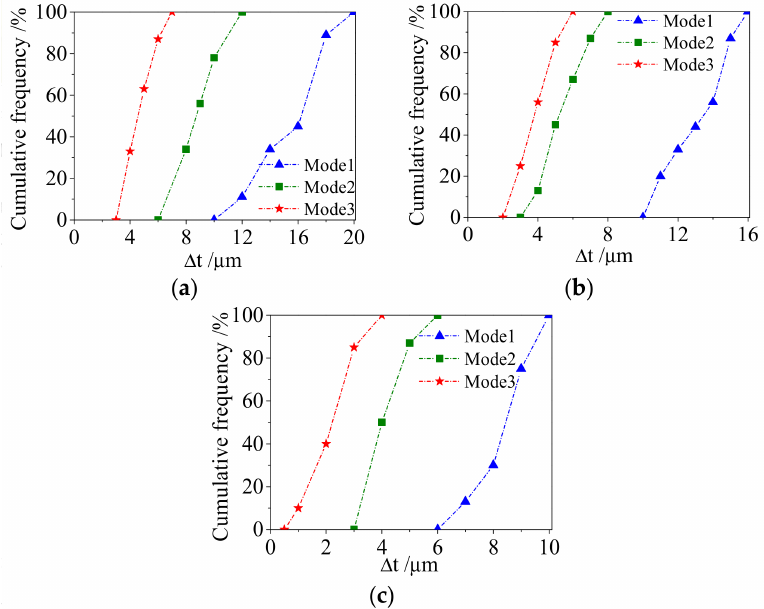
Figure9. Effectofthecuringmodesonthethicknessuniformity. ( a ) ∆ ρ = 0.0068g / cm 3 ; ( b ) ∆ ρ = 0.0044 g / cm 3 ; ( c ) ∆ ρ = 0.0004 g / cm 3